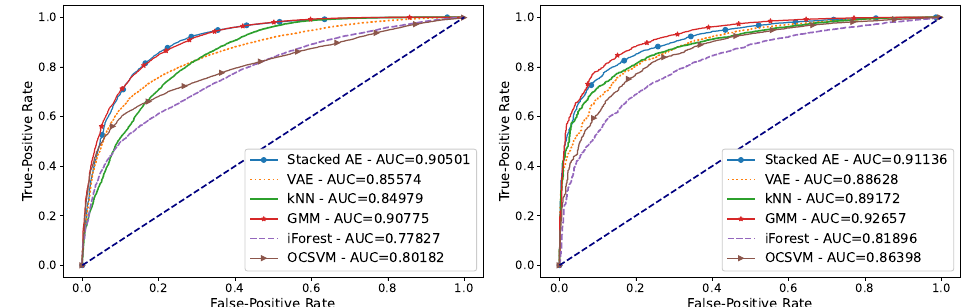
Figure 2. The AUC curves of the best performances obtained in the AND scenario in which only one event is known on the datasets: ( a ) Domestic, ( b ) ESC-10, ( c ) US8K, and ( d ) ESC-50. When most of the events were known, but only one event was unknown, VGG and F-TDNN provided the best novelty detection performances within most of the AND experiments. The AND performances of the features with the best AND methods are demonstrated in Figure 3a–d, which were obtained in the most complicated AND scenario; that is, only one event was